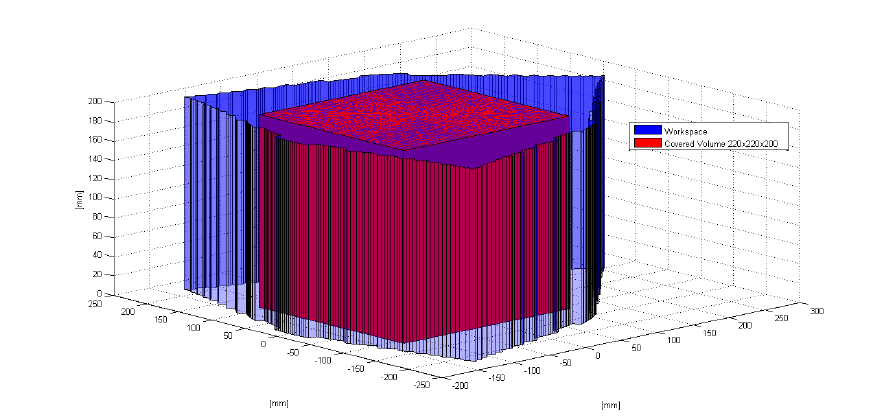
Figure 6. Linear delta